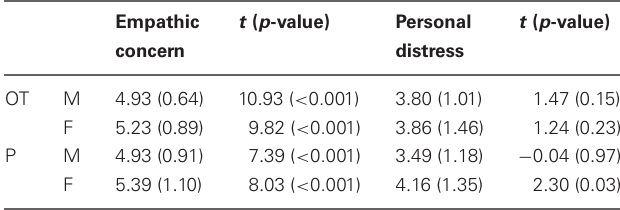
Table 1 | Mean empathic concern ratings and their difference from chance level (3.5) for the two sexes in each drug